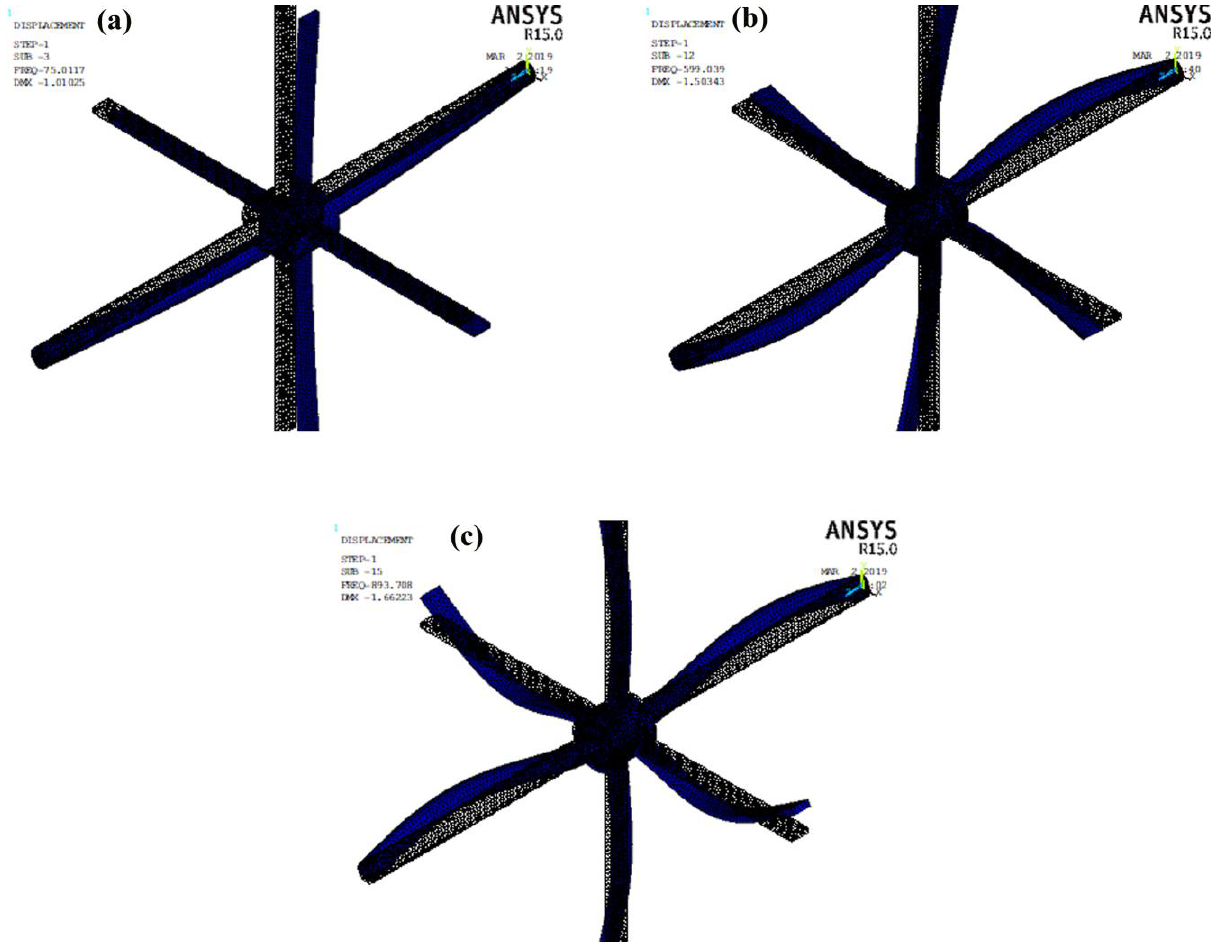
Figure 8. ( a ) First mode, ( b ) second mode and ( c ) third mode of the rotating